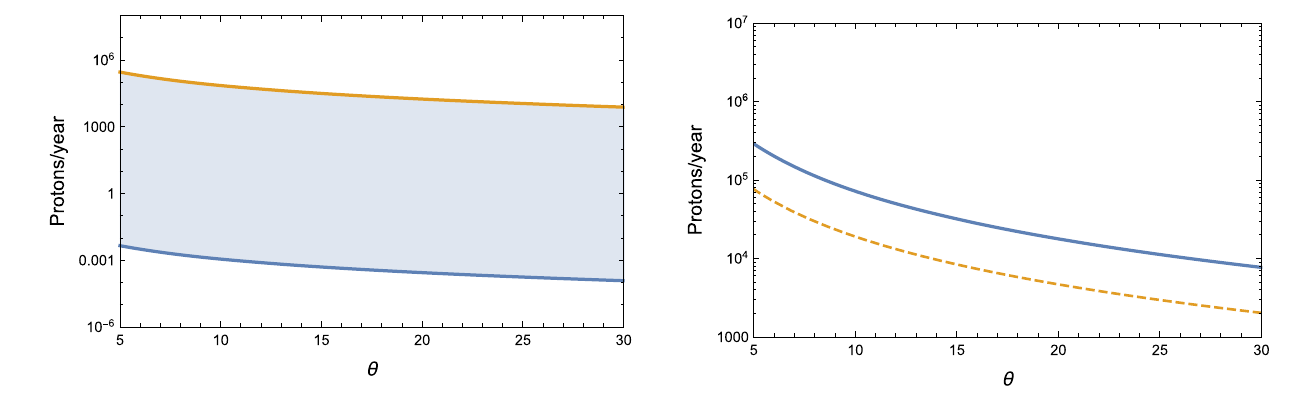
Fig. 3 We show the average number of protons scattered in one year from a 7 TeV proton beam at an LHC luminosity of 2 10 34 cm − 2 s − 1 by a monopole–anti-monopole separating at velocity β = 0 . 01 as a function of scattering angle for the geometry that maximises the cross section. The upper curve corresponds for a dipole of d ∼ 240 fm and the lower for a dipole of d ∼ 0 . 03 fm values which have been justified in the text